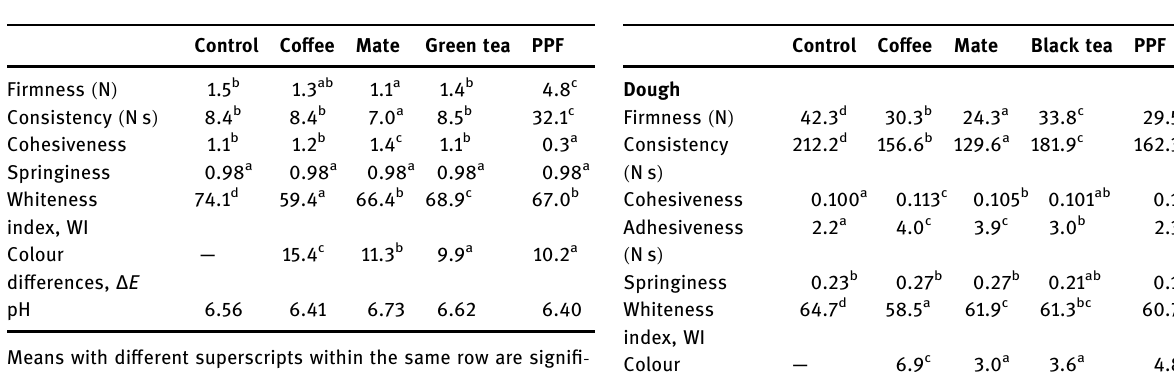
Table 3: Physical characteristics of dough and biscuits prepared from 55:45 wheat fl our:maize starch blend fl our with infusions or with Prosopis chilensis pod fl our ( PPF )